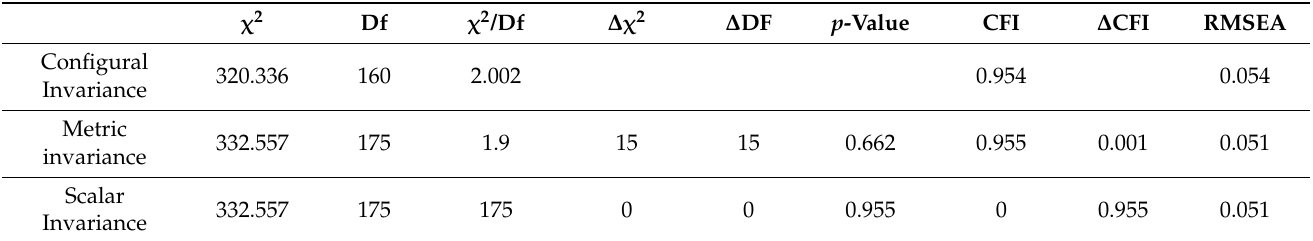
Table 8. Model Fits for Invariant Test across Gender Training in the General Domain.